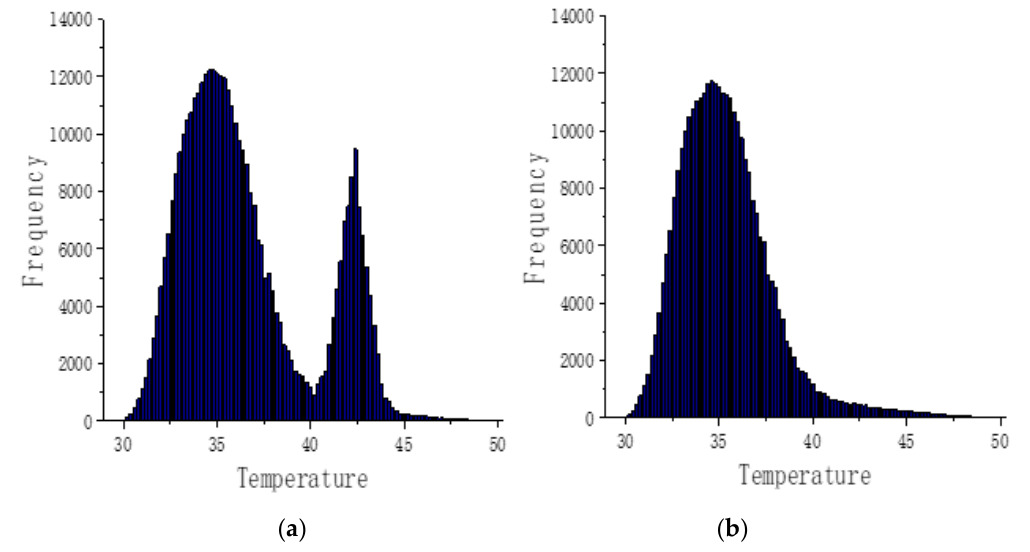
Figure 5. Histogram of the infrared thermal image temperature, ( a ) Temperature histogram of the raw infrared thermal image and, ( b ) Temperature histogram after removing the soil background.